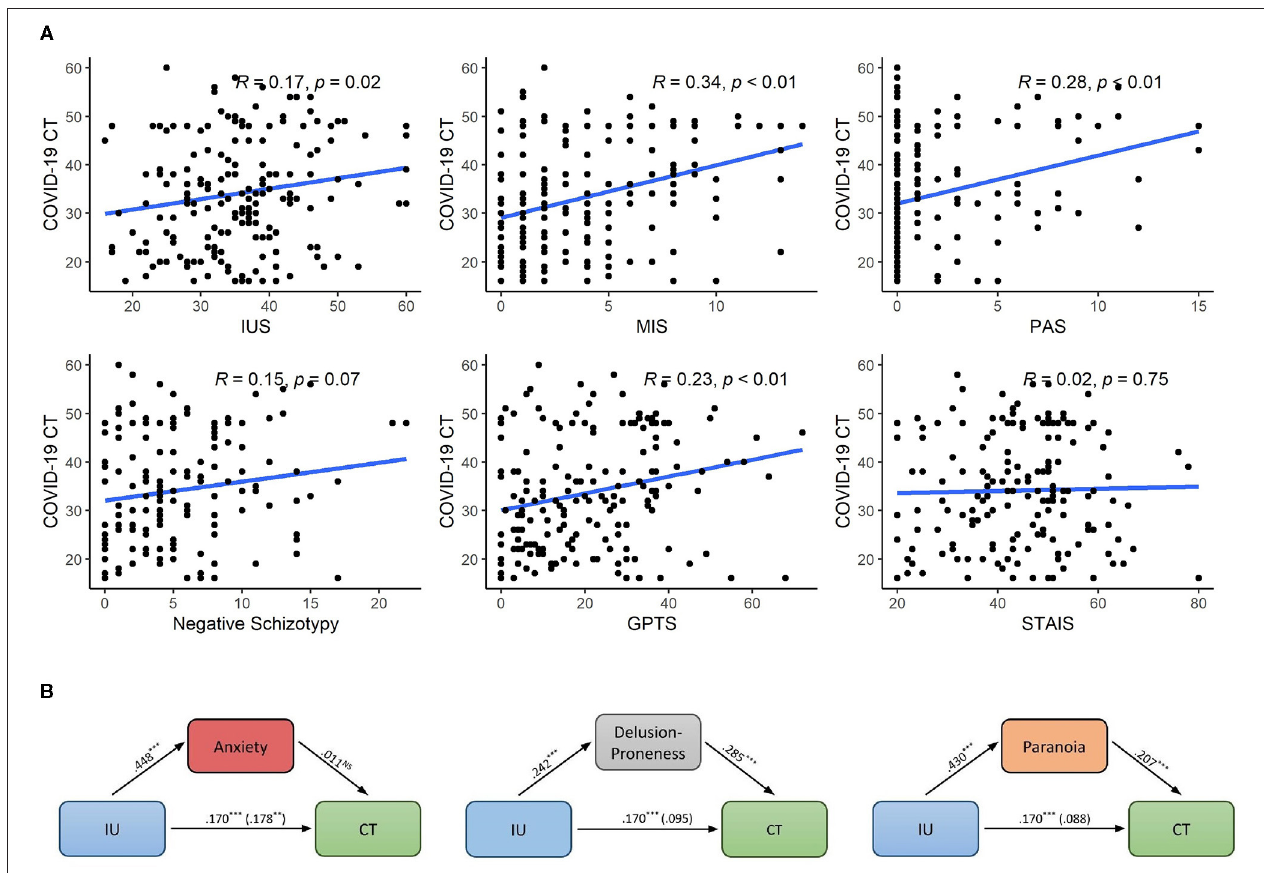
FIGURE 2 | (A) Relationships of individual difference measures with CT in Study 2. Correlation coefficients for PAS and Negative schizotypy represent Spearman’s Rho while all others represent Pearson’s R. (B) Mediation paths for three possible factors explaining the relationship between IU and CT. CT, Conspiratorial thinking; IUS, Intolerance of Uncertainty Scale; MIS, Magical Ideation Scale; PAS, Perceptual Aberration Scale; GPTS, Green et al. Paranoid Thought Scale. ** p < 0.01, *** p <